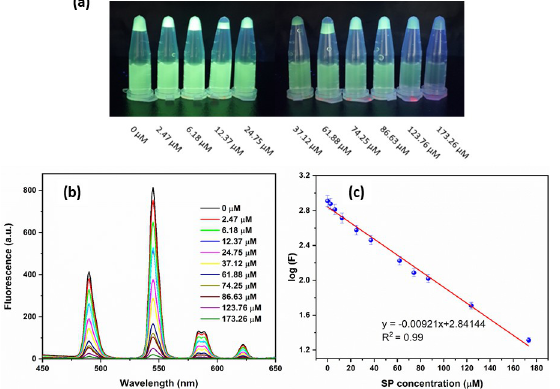
Fig 4. (a) Images of CP-Tb 3+ complex with different concentrations of SP; (b) Fluorescence spectra of CP-Tb 3+ with different concentrations of spermine (0–173 μ M) in PBS buffer solution (pH 7); and (c) Linear relationship between log(F) and spermine